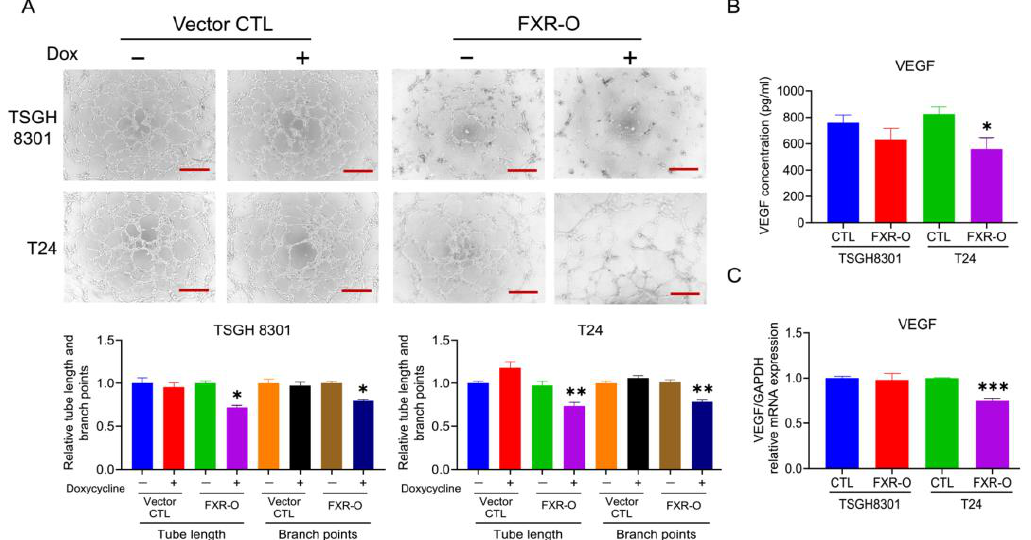
Figure 7. The effect of the overexpression of FXR on angiogenesis. ( A ) The human umbilical vein endothelial cells (HUVECs) were cultured with an FXR overexpression (72 h) conditioned medium (CM) and control CM of bladder cancer cells for 6 h. The formation of endothelial cell networks was observed and the number of branch points and tube length in the TSGH8301 and T24 CM were analyzed. The bar graphs show the quantitative results of relative branch points and tube lengths. Scale bar = 200 µ m. ( B ) The concentration levels of vascular endothelial growth factor (VEGF) in the CM of TSGH8301 and T24 cells were analyzed by ELISA. ( C ) RT-PCR was used to analyze the mRNA expression of VEGF after FXR overexpression in TSGH8301 and T24 cells. * p < 0.05; ** p < 0.01; *** p < 0.001 compared with the control group.